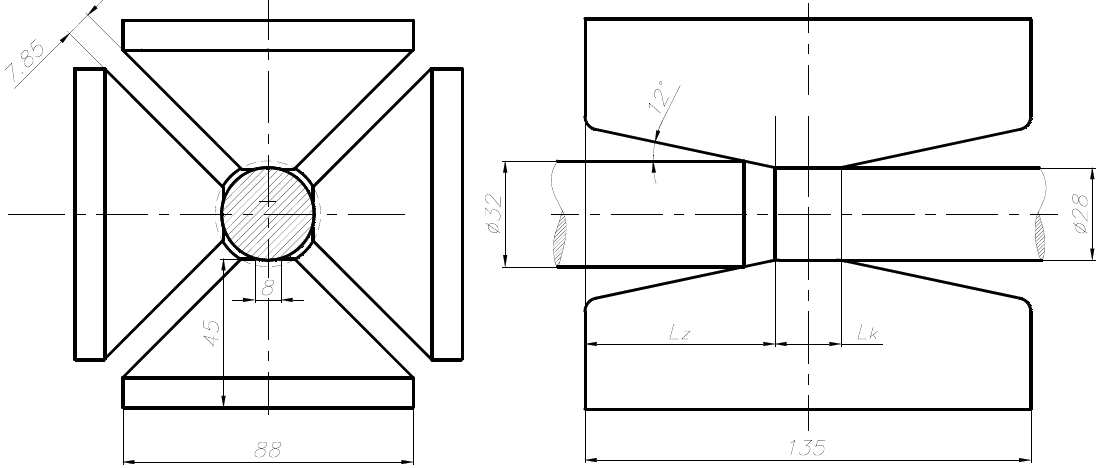
Figure 4. Diagram of the rod cold swaging